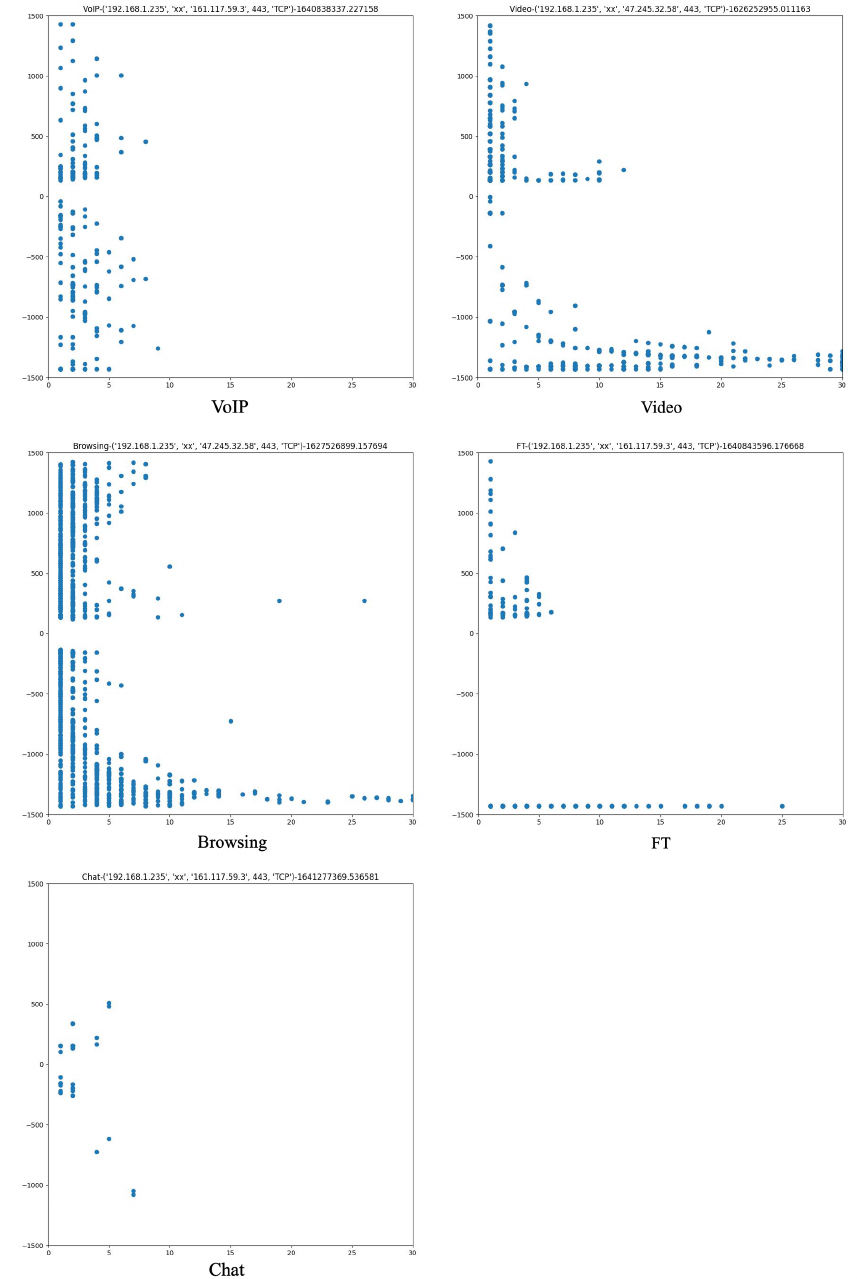
Figure 3. Example of Packet Block